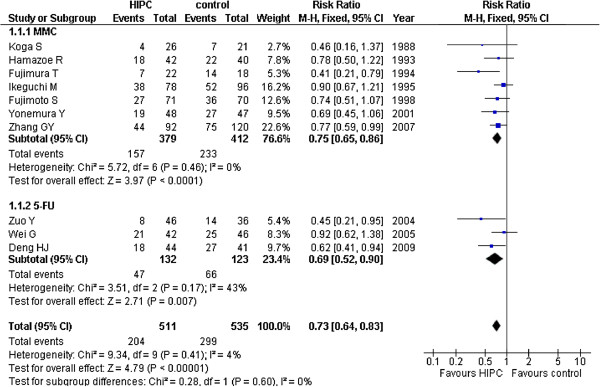
Risk Ratios for overall survival rates of all 10 randomized controlled trials.